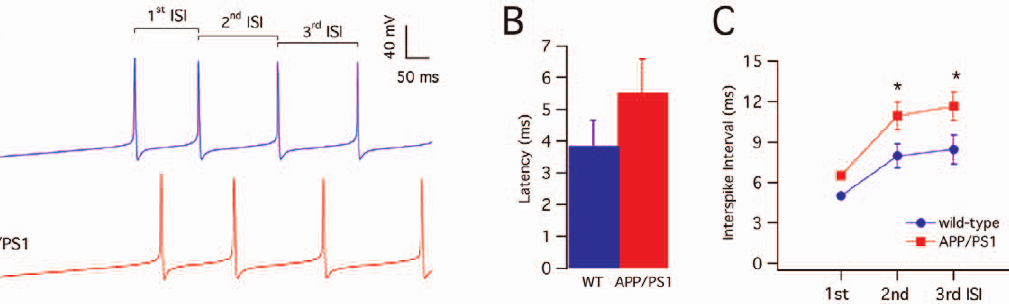
Figure 2. Evoked firing properties of APP/PS1 PCs. ( A ) Wild-type (blue) and APP/PS1 (red) PC evoked action potential firing. In the wild-type trace, the first three interspike intervals (ISI) are shown. ( B ) Mean latency of the first spike for PCs from wild-type (n=14) and APP/PS1 (n=20). The difference is not significant (P . 0.05). ( C ) Plot of the first three ISIs of wild-type (n=14) and APP/PS1 (n=20) mice PCs. The second and third ISIs are significantly prolonged in APP/PS1 mice (*p , 0.05, t test).